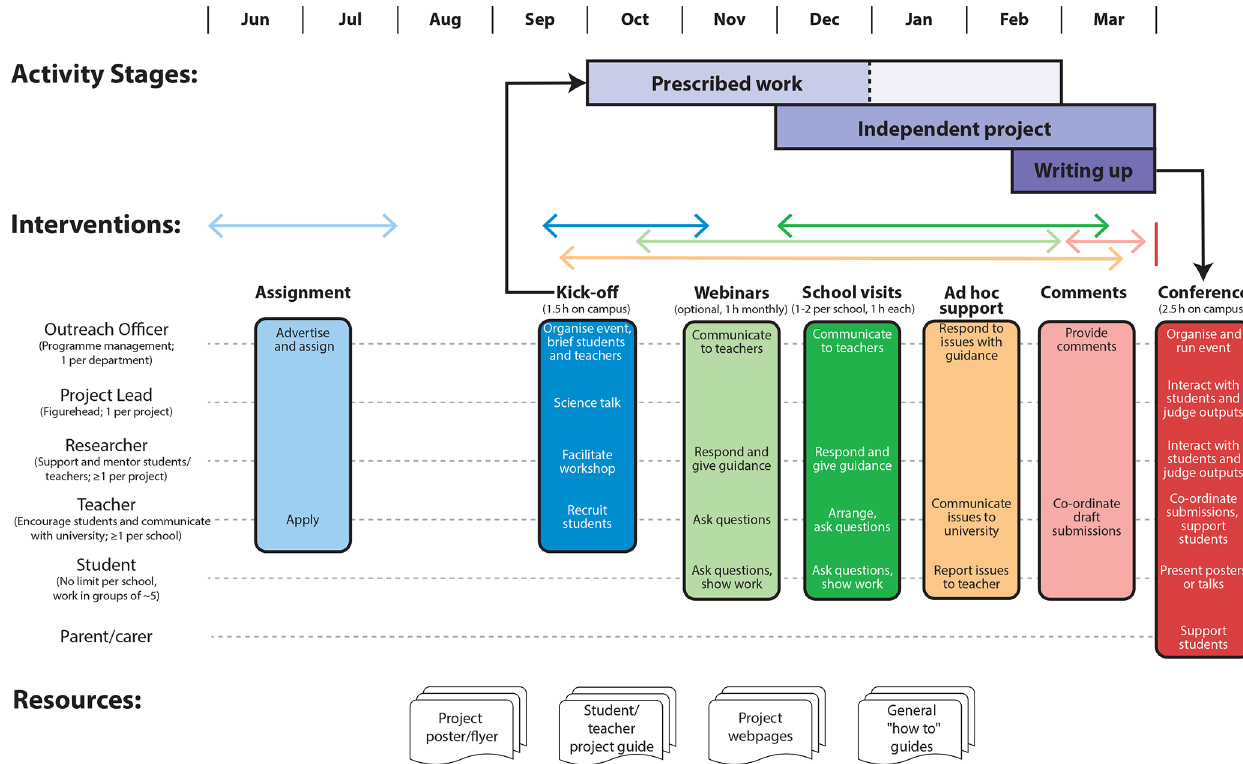
Figure 1. Graphic summarising the PRiSE framework including a timeline of the different project activity stages (rectangles), interventions and stakeholders’ roles within them (rounded rectangles), and resources provided (document shapes). Arrows indicate over what dates interventions (identified by colour) typically